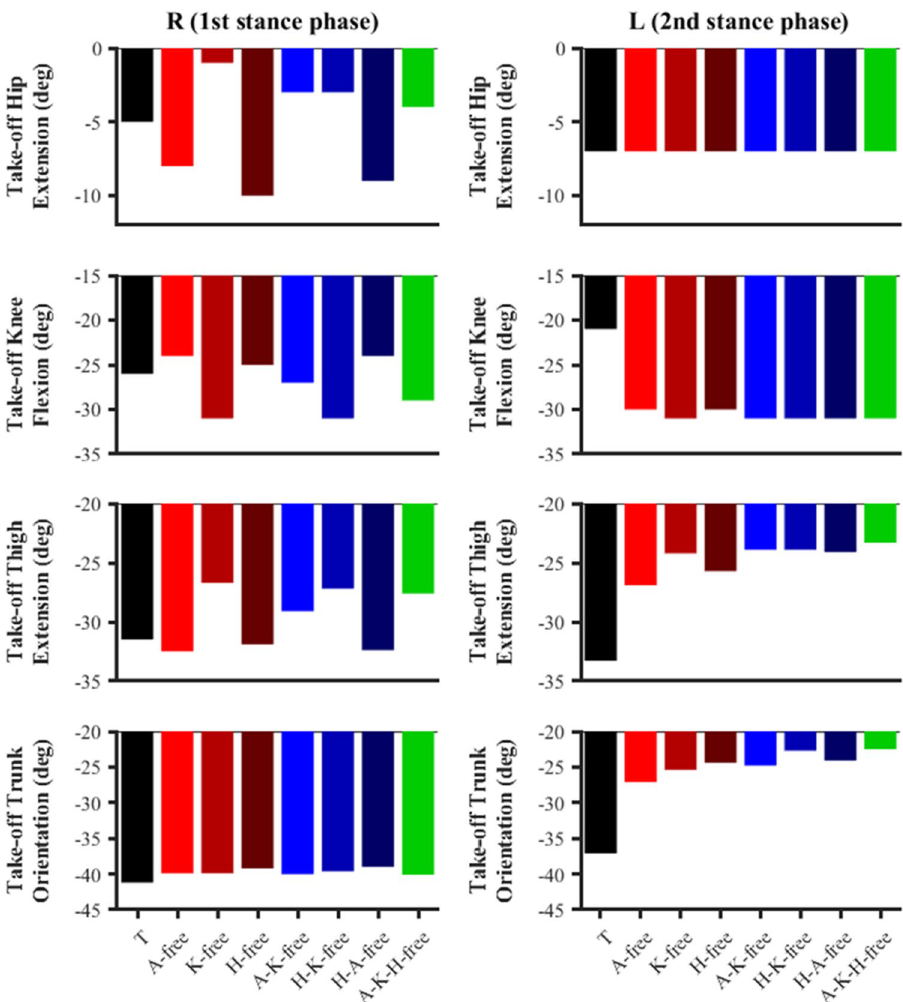
Figure 6. Right (R) and left (L) hip extension, knee flexion, thigh extension and trunk orientation angles at take-off for the data-tracking (T) and predictive simulations (A-free, K-free, H-free, A-K-free, H-K-free, H-A- free, A-K-H-free). Full knee extension = 0° and knee flexion is negative; thigh aligned vertically with pelvis corresponds to hip flexion–extension = 0°, and hip flexion is positive and hip extension is negative. Thigh and trunk segment angles are defined relative to the vertical axis of the global coordinate system. Negative thigh and trunk segment angles (clockwise rotations) correspond to extension and forward inclination, respectively. These are consistent with the model’s